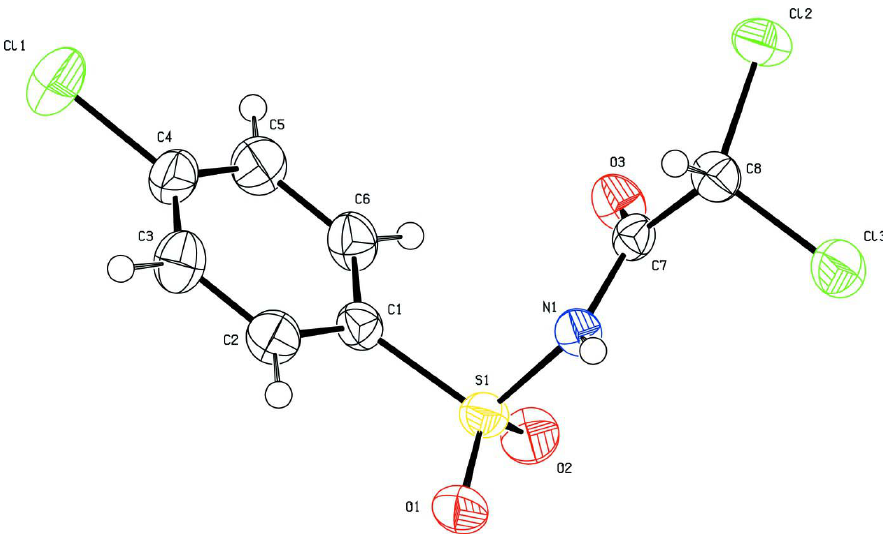
Figure 1 Molecular structure of the title compound, showing the atom labeling scheme. Displacement ellipsoids are drawn at the 50% probability level. H atoms are represented as small spheres of arbitrary radii.